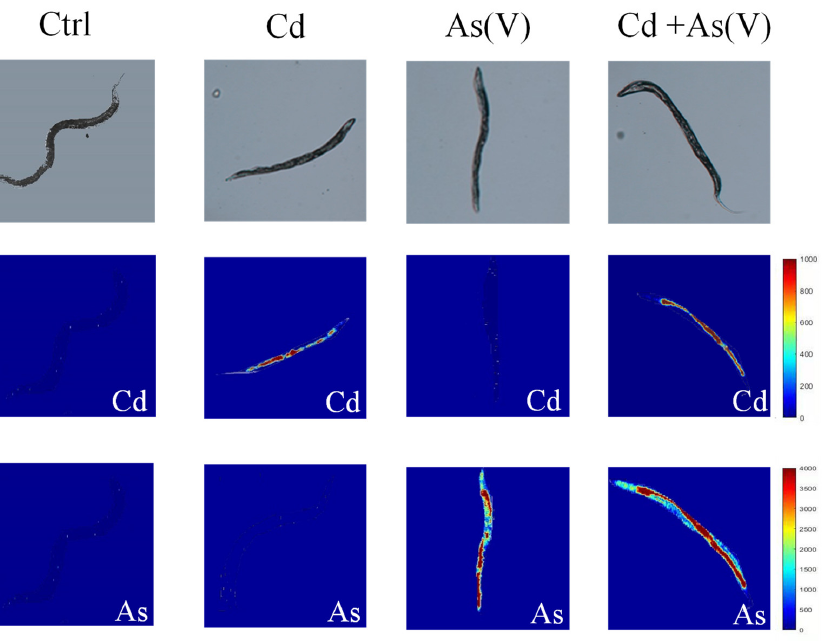
Figure 4. Spatial distribution of Cd and As in C. elegans exposed to Cd, As(V), and Cd-As(V).